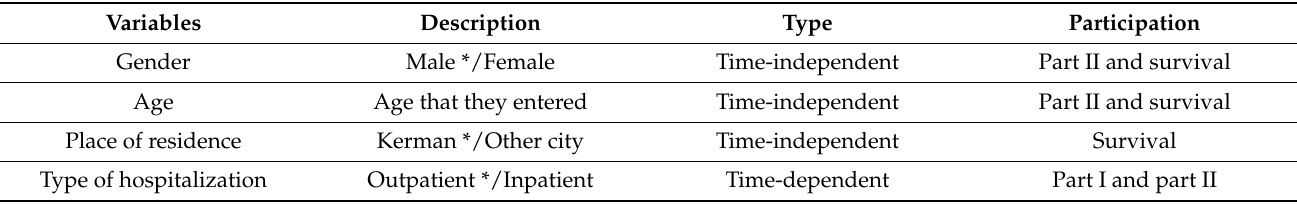
Table 4. Variable description.